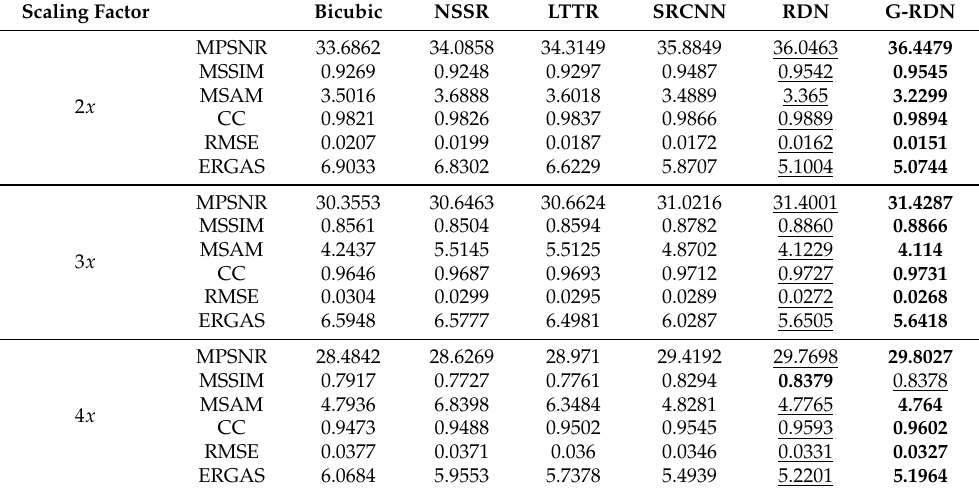
Table 2. Average measurement metrics for the Pavia Center